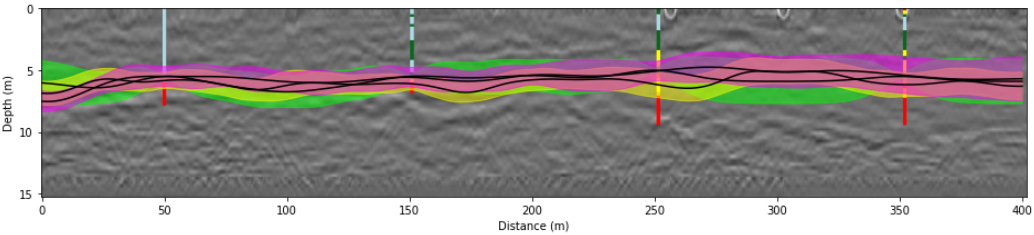
Figure 15. Comparison of the different geologist responses in the second GPR profile.